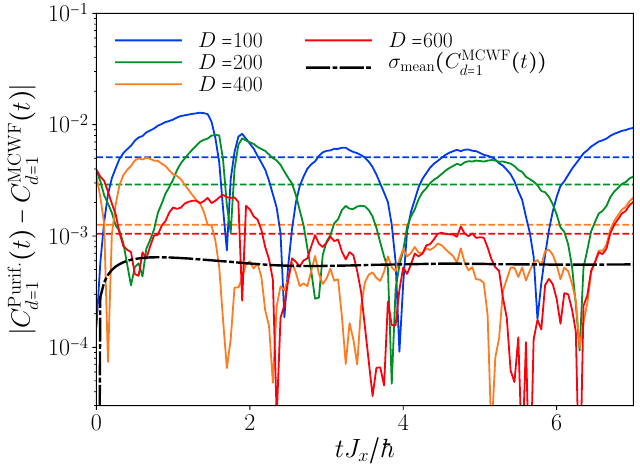
Figure 18: Comparison of the evolution of the equal-time correlation function under the dissipator D . We present the deviation of the simulation results using the purifi- 2 cation approach with different values for the maximal bond dimension from MCWF data using 3 × 10 4 samples and D = 500 (solid lines). We evolve a chain of size = 2 and J / J = 0.5. The time step is chosen as ∆ tJ L = 29 with (cid:126) γ/ J x z x in all cases. The dashed lines mark the time average over the presented time interval and the dashed-dotted line is the time-dependency of the standard deviation of the Monte-Carlo average.